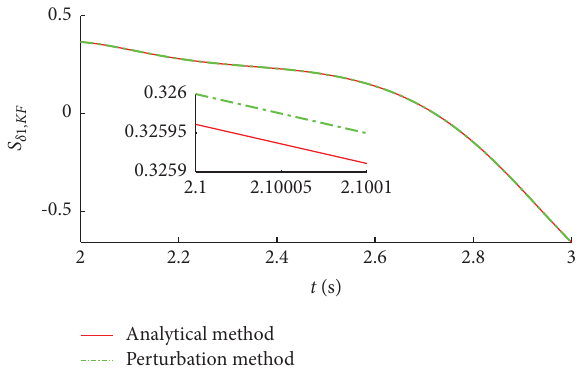
Figure 6: Trajectory sensitivity of the power angle of #1 SG to K